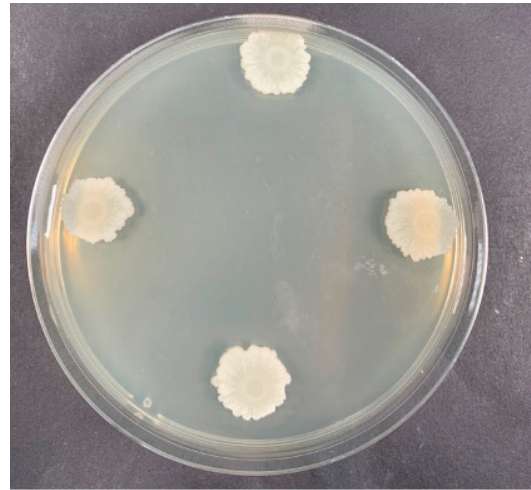
Figure 4. Morphology of the colony of strain B72.